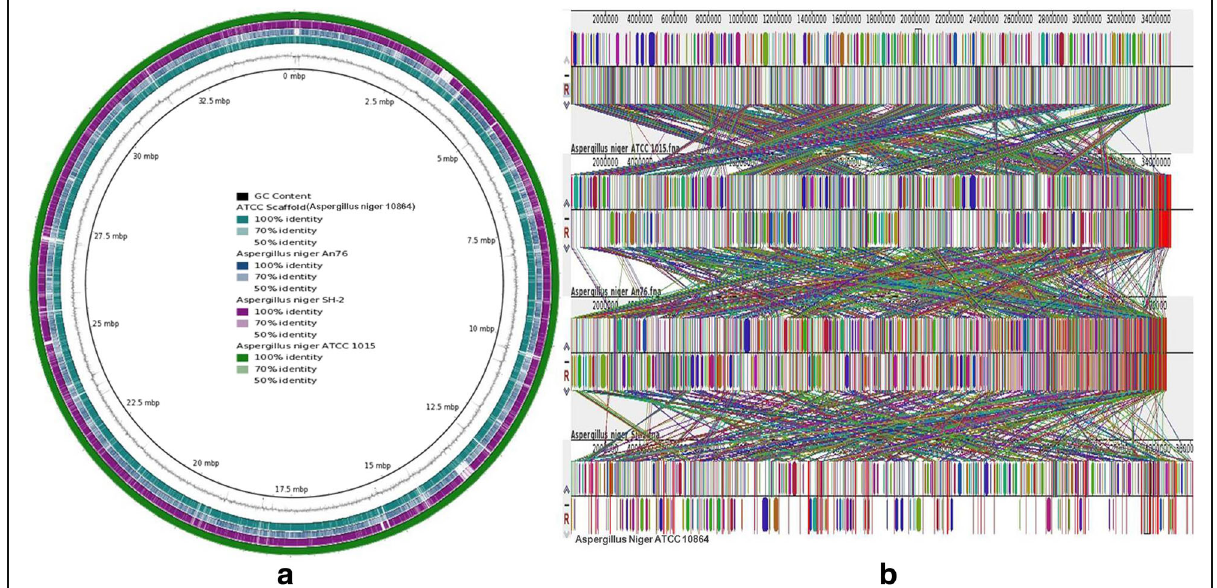
Fig. 3 Whole genome comparison analysis of A. niger ATCC 10864 with other reported A. niger strains. a Comparison of A. niger ATCC 10864, A. niger An76, and A. niger SH-2 strains against reference A. niger ATCC 1015 strain (using BRIG tool). The outermost dark green circle represents the reference genome of A. niger ATCC 1015; the next purple , blue and light green circle represent A. niger SH-2, A. niger An76, and A. niger ATCC 10864 strains respectively. The black line lying in between the A. niger ATCC 10864 and genome-scale symbolize the GC content. b Comparison of A. niger ATCC 10864, A. niger An76, and A. niger SH-2 strains against reference A. niger ATCC 1015 strain (using Mauve tool). Colored block outlines are known as Locally Collinear Blocks and are connected by corresponding coloured lines. LCBs represent the regions of similarity among the genomes that are homologous and have not undergone any rearrangement. Blocks lying above the center black horizontal line are in forward orientation while blocks below the center line indicate regions that align in the reverse complement ( inverse ) orientation. Regions outside blocks ( white regions) show no homology among the input